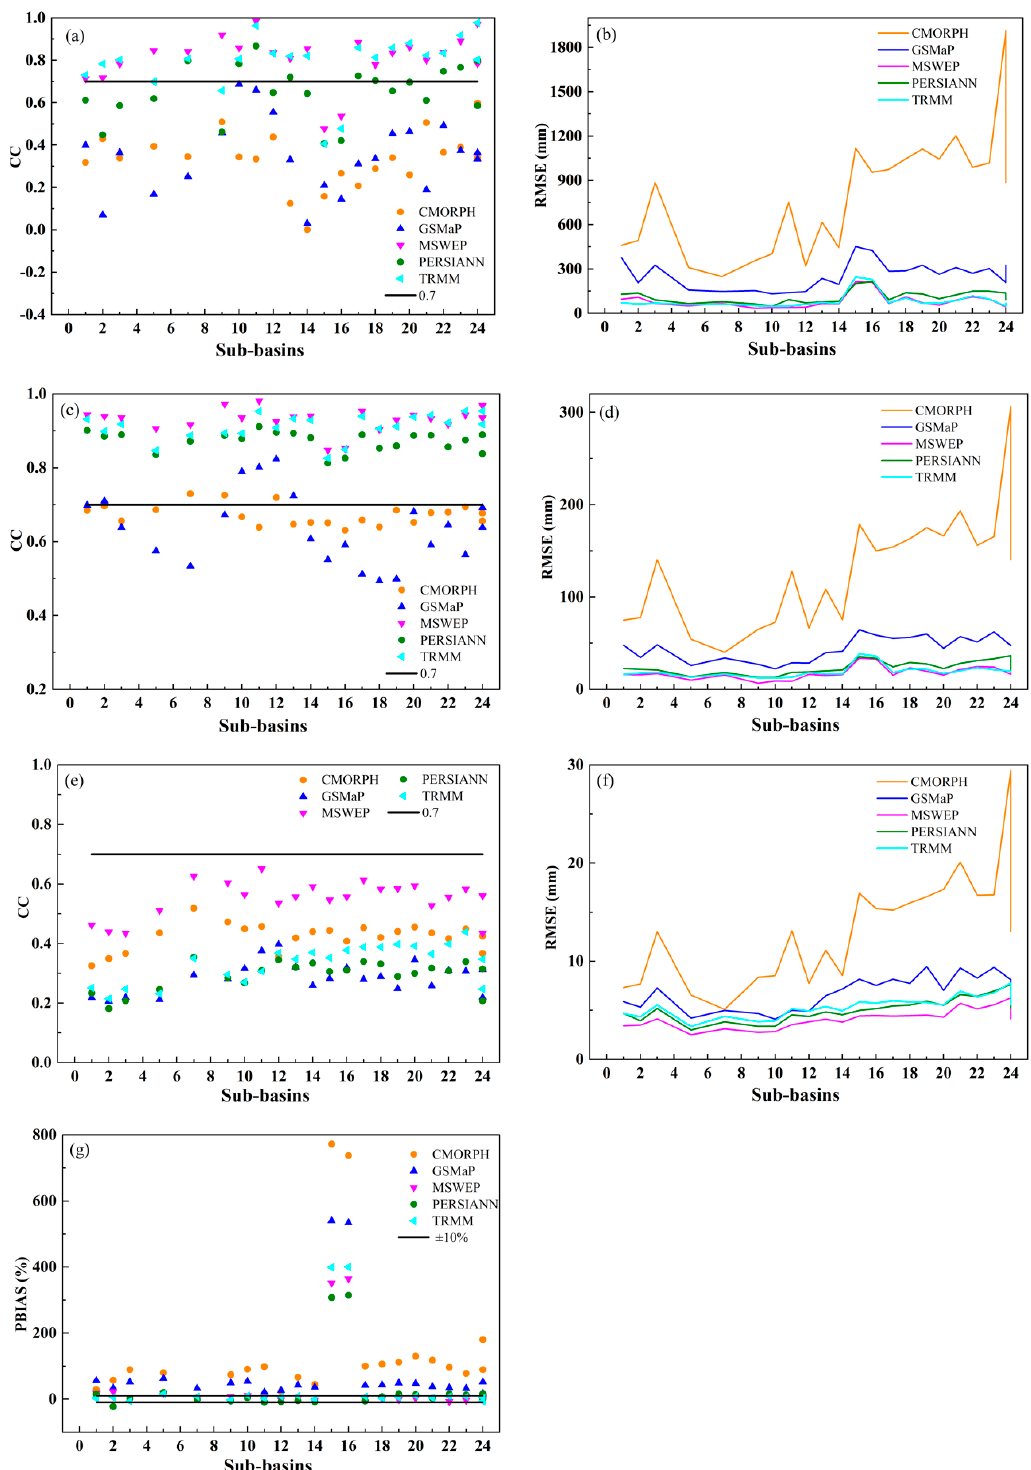
Figure 13. ( a ) annual correlation coefficient and ( b ) root mean square error, ( c ) monthly correlation coefficient and ( d ) root mean square error, ( e ) daily correlation coefficient, ( f ) root mean square error and ( g ) PBIAS in sub-basins. CC is correlation coefficient, RMSE is root mean square error, PBIAS is bias. (The black line in ( a ), ( c ) and ( e ) means the correlation coefficient is equal to 0.7, above which the variables were significantly correlated. The upper black line in ( g ), means PBIAS is equal to 10% and the lower black line means PBIAS is equal to − 10%, between which the PBIAS is acceptable.).